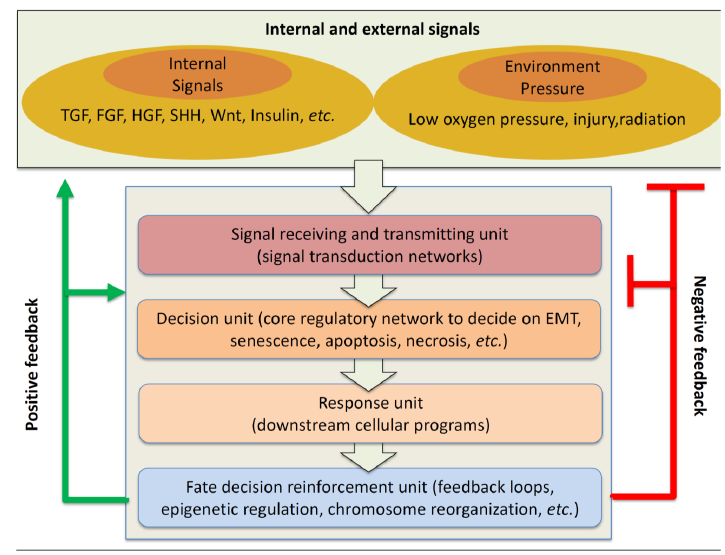
Figure 1. Schematic of the overall signal reception, transduction, and response process of EMT. Intracellular and extracellular signals are relayed via four basic units and regulated by positive and negative feedback loops.